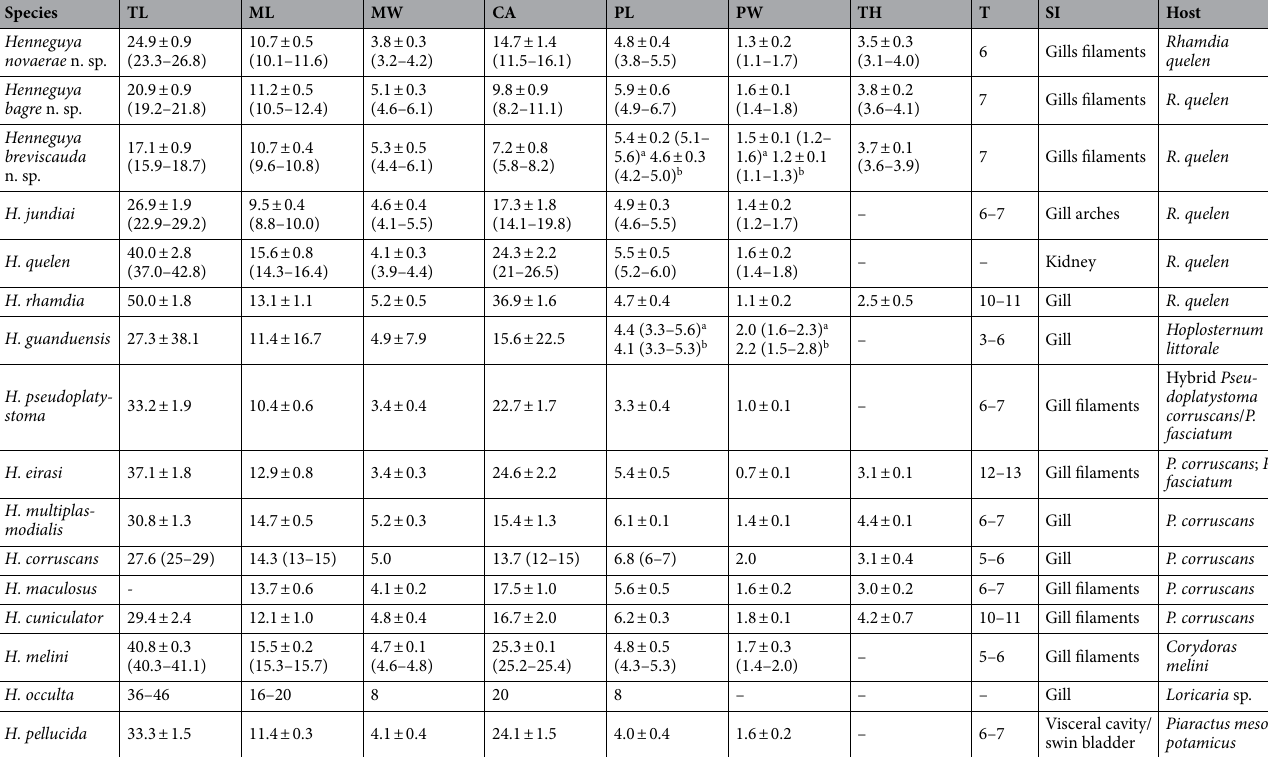
Table 2. Comparative data for the three new species described and Henneguya spp. from siluriform fishes from South America. All measurements are in µm. TL = total length; ML = myxospore body length; MW = myxospore body width; CA = caudal appendages length; PL = polar capsule length; PW = polar capsule width; TH = thickness; T = number of turns of the polar filament; SI = site of infection. a Larger polar capsules; b Smaller polar